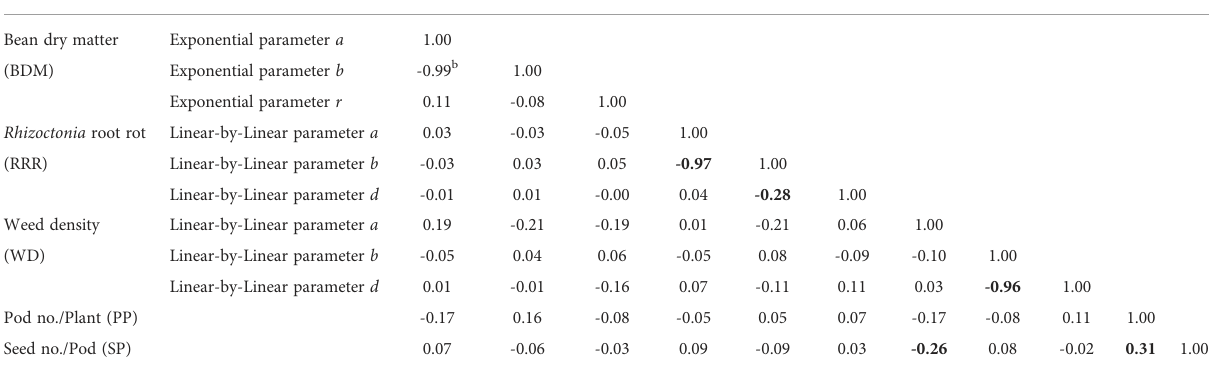
TABLE 4 Correlations between descriptors of plant production, Rhizoctonia root rot, and weed development in bean cultivars planted under different dates and weed control treatments.